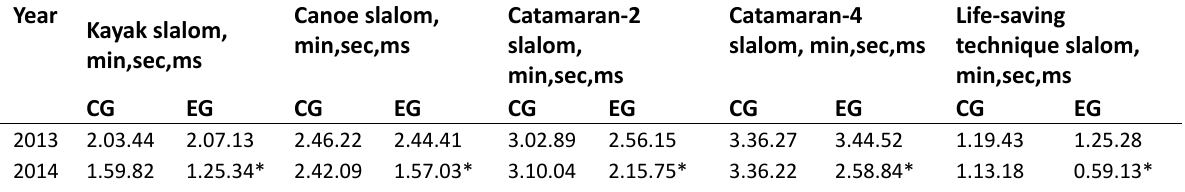
Table 2. Results of the Athletes’ Performance at the Sports Water Tourism Championship